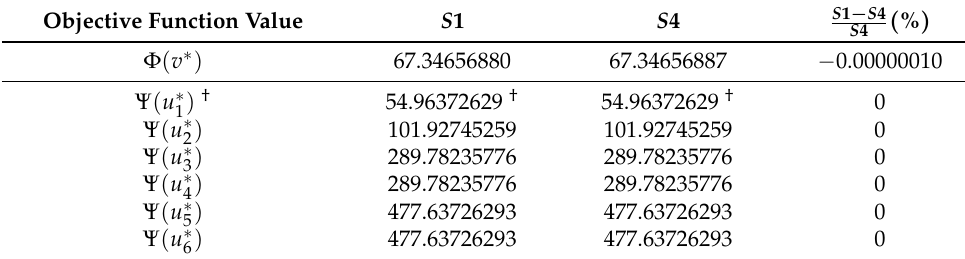
Table 5. Performance analysis: S 1 vs. S